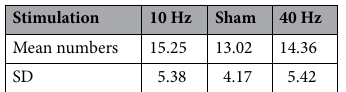
Table 2. Number of words produced by phonemic fluency.